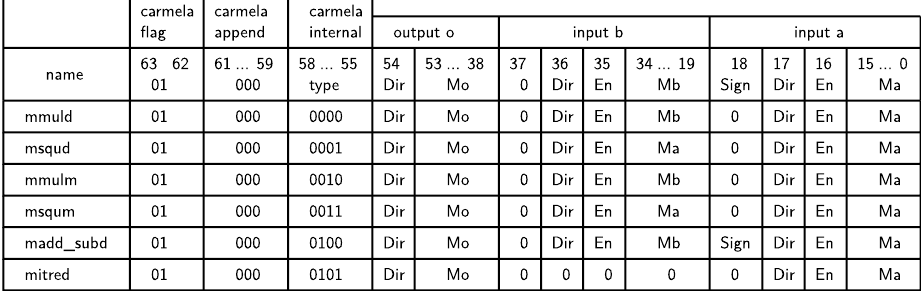
Figure 18: The Carmela coprocessor instructions for the SIKE